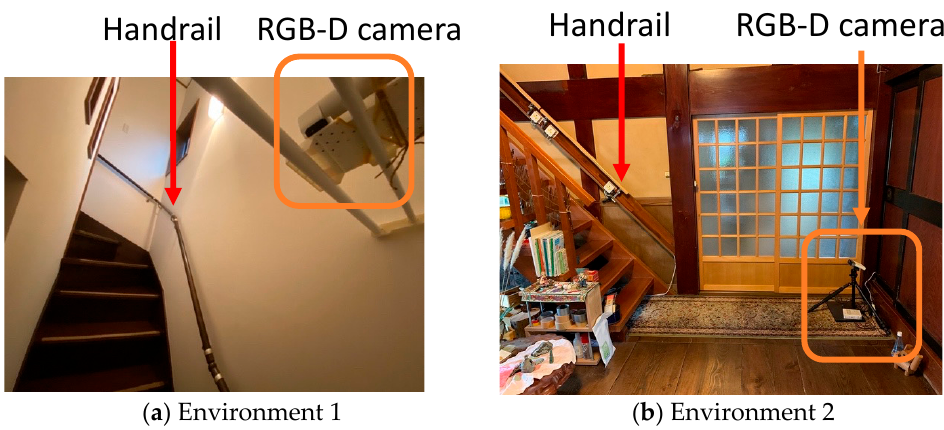
Figure 1. Stair, handrail, and RGB-D camera in the measurement environment.